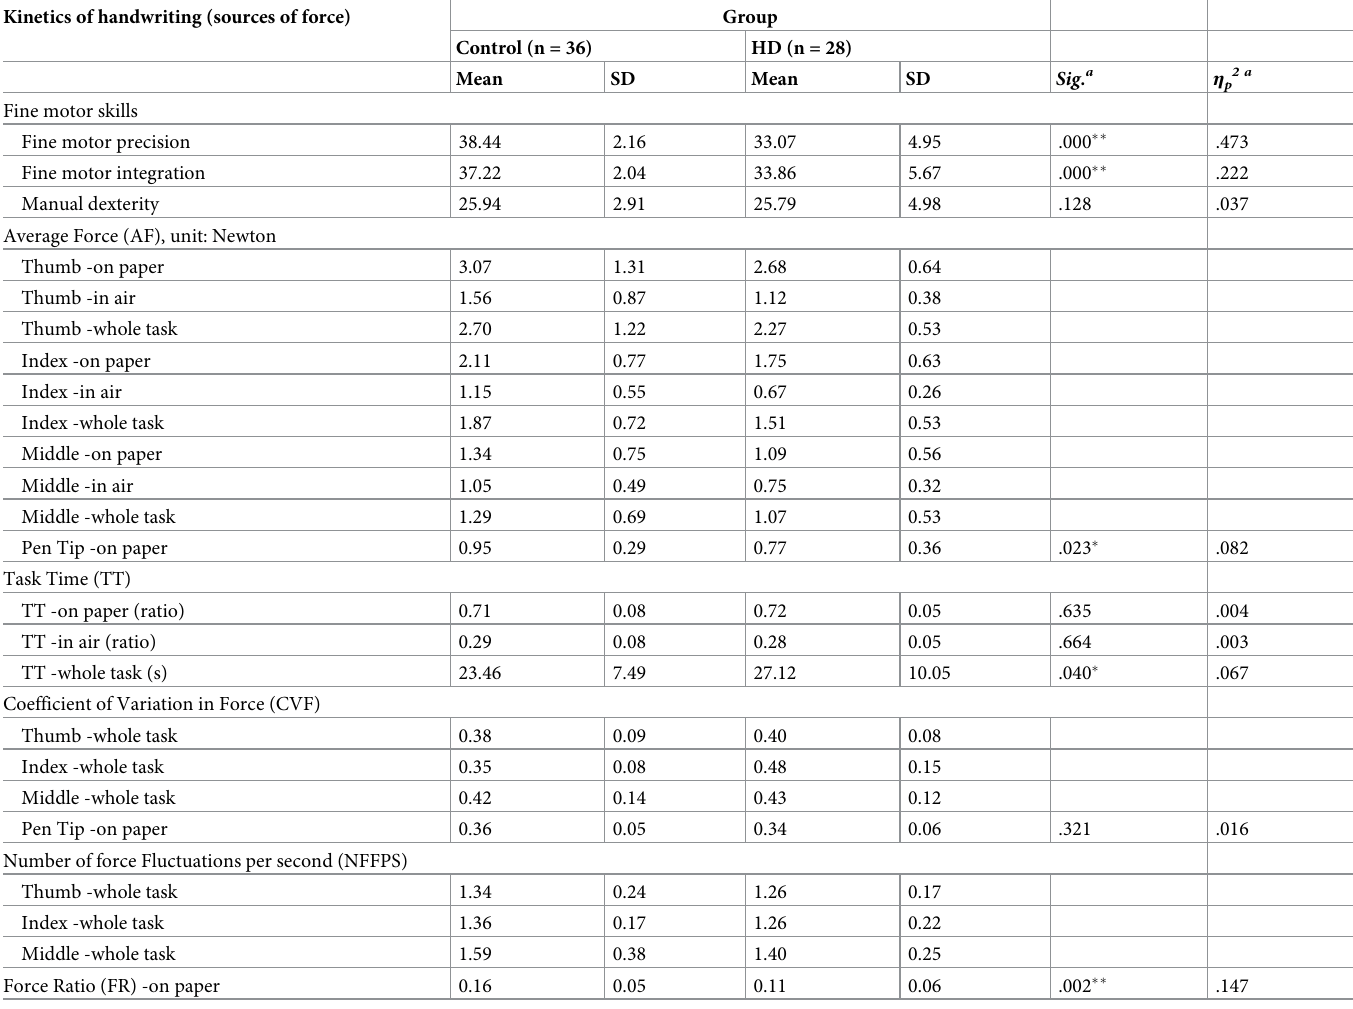
Table 2. Descriptive statistics data in two groups and the ANCOVA results for between-group difference. Kinetics of handwriting (sources of